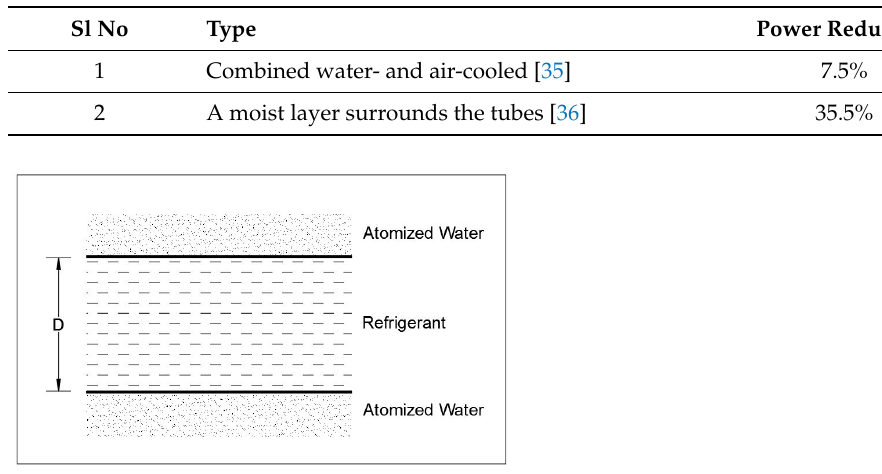
Table 1. Power saved with different condensers.